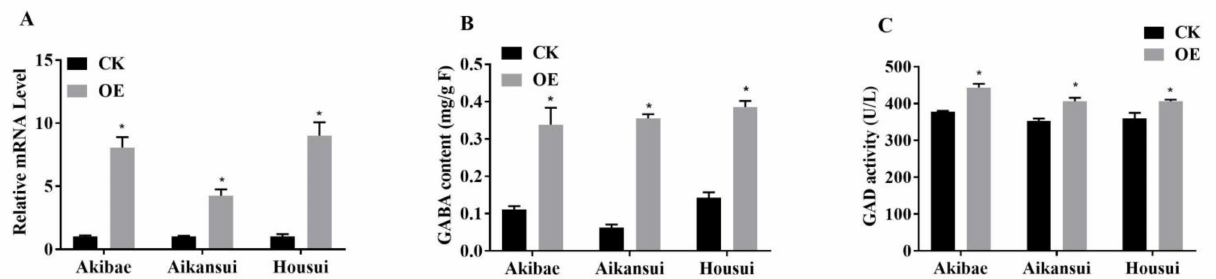
Figure 5. Transient overexpression of PpGAD2 in three pear cultivars (‘Aikansui’, ‘Akibae’ and ‘Hosui’). ( A – C ) refer to PpGAD2 gene expression, GABA content and GAD activity, respectively. The asterisk on the bars represent standard errors from three independent replicates when compared to CK of each variety itself. * p < 0.05. CK and OE refer to vector only and PpGAD2 over-expression, respectively.